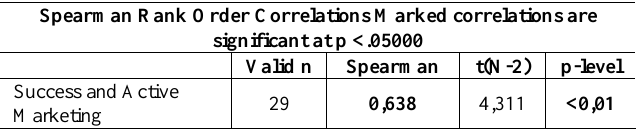
Table 10: Active marketing and alliance success Spearman Rank Order Correlations Marked correlations are significant at p <.05000